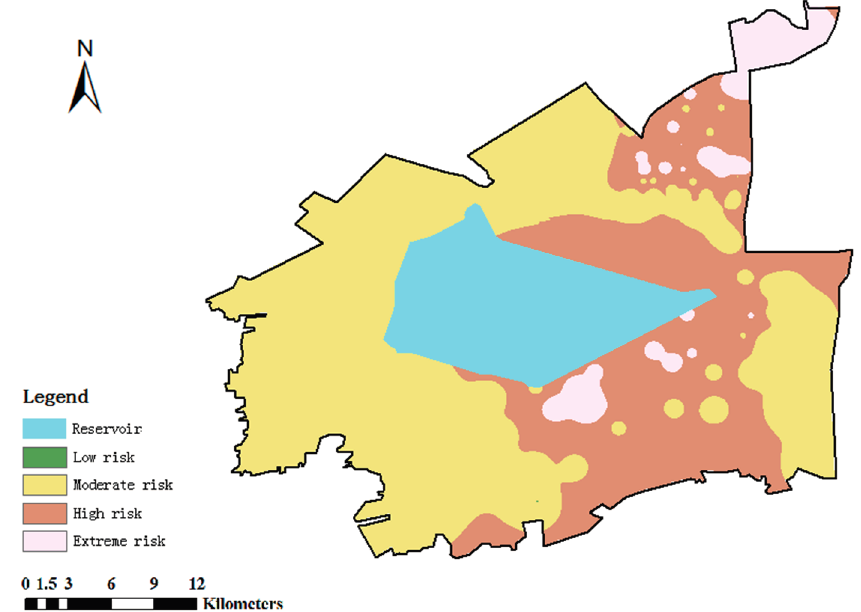
Figure 4. Spatial distribution map of the human health risks posed by contaminated soil.